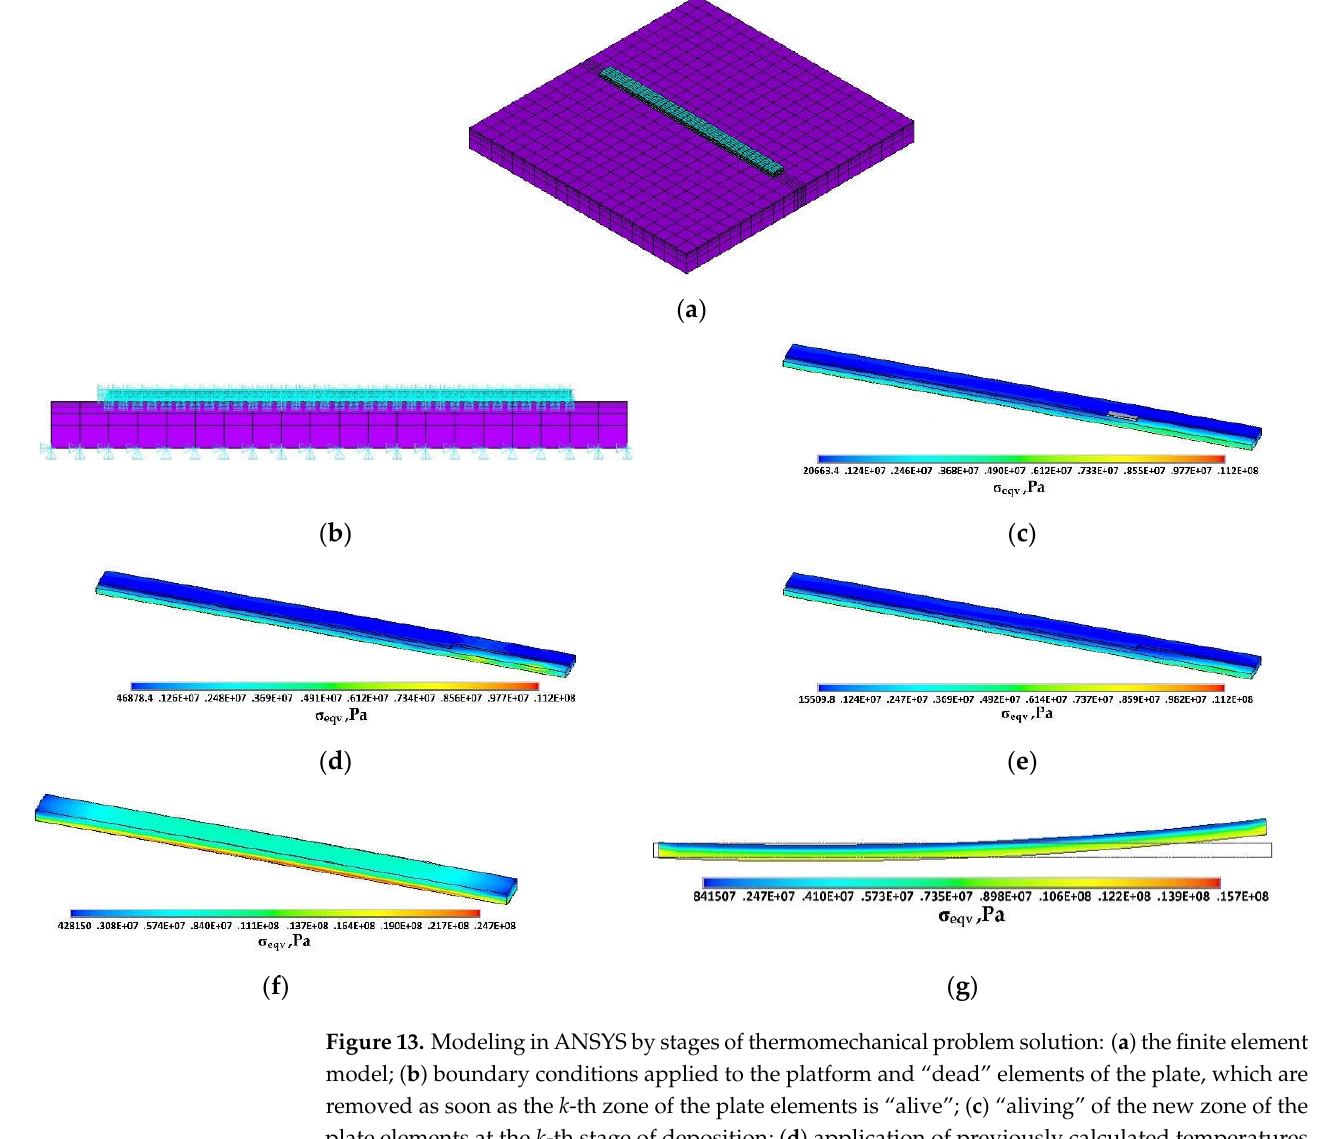
Figure 13. Modeling in ANSYS by stages of thermomechanical problem solution: ( a ) the finite element model; ( b ) boundary conditions applied to the platform and “dead” elements of the plate, which are removed as soon as the k -th zone of the plate elements is “alive”; ( c ) “aliving” of the new zone of the plate elements at the k -th stage of deposition; ( d ) application of previously calculated temperatures after the heating of the zone of plate elements at the k -th stage of deposition; ( e ) application of previously calculated temperatures after the cooling of the zone of the plate elements at the k -th stage of deposition; ( f ) application of ambient temperature to system; ( g ) separation of the plate from the platform.